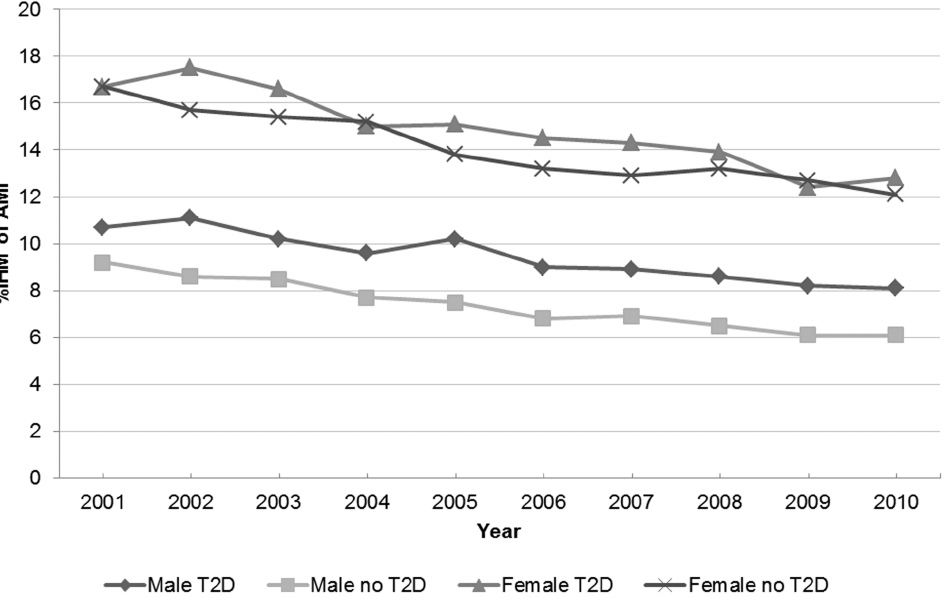
Figure 1. In-hospital mortality after AMI in patients with and without type 2 diabetes according to sex. IHM of AMI: In-hospital mortality after acute myocardial infarction. Male T2D: Men with type 2 diabetes. Male no T2D: Men without type 2 diabetes. Female T2D: Women with type 2 diabetes. Female without T2D: Women without type 2 diabetes. doi:10.1371/journal.pone.0085697.g001 PLOS ONE |